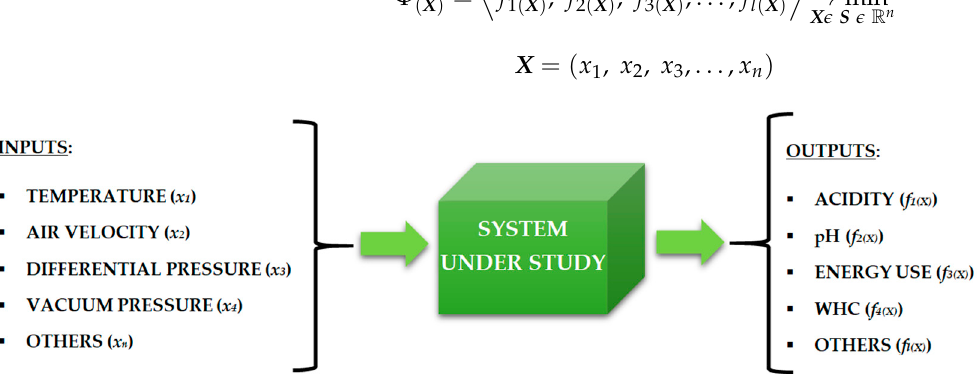
Figure 4. Input and output variables correspond with several different food-processing systems.